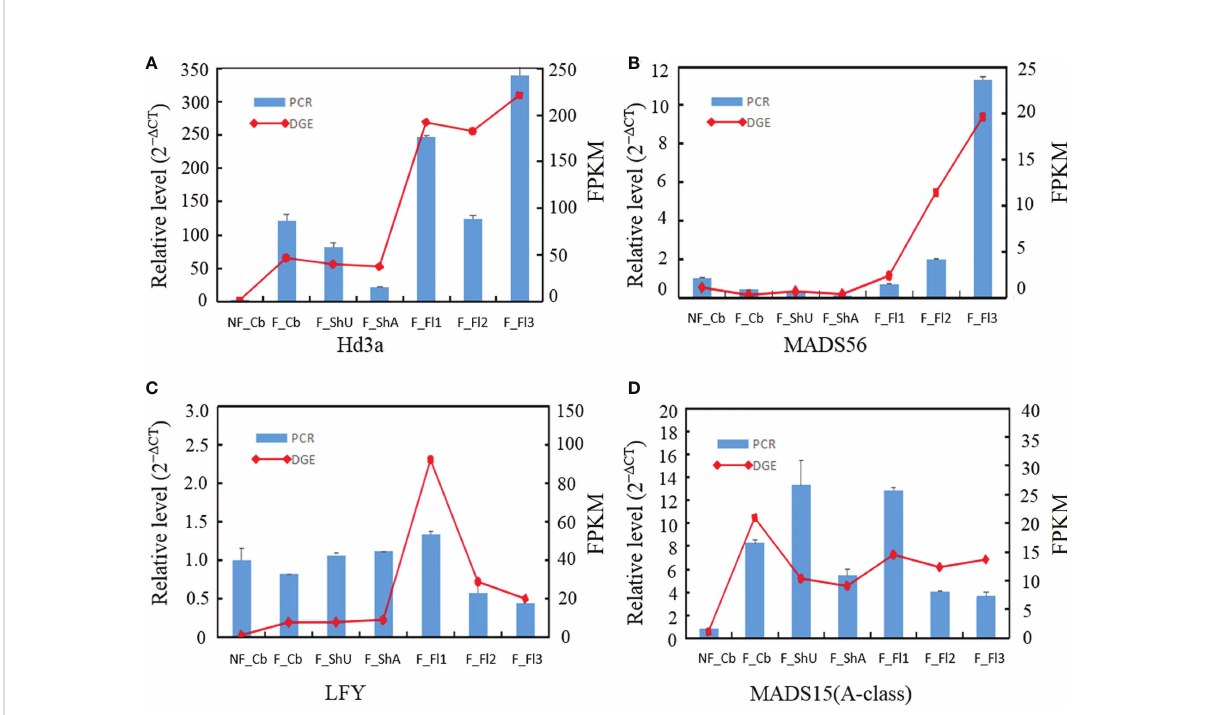
FIGURE 4 qRT-PCR validation of the expression for four selected genes in different developmental stages. The transcript levels were normalized to that of PP2A and